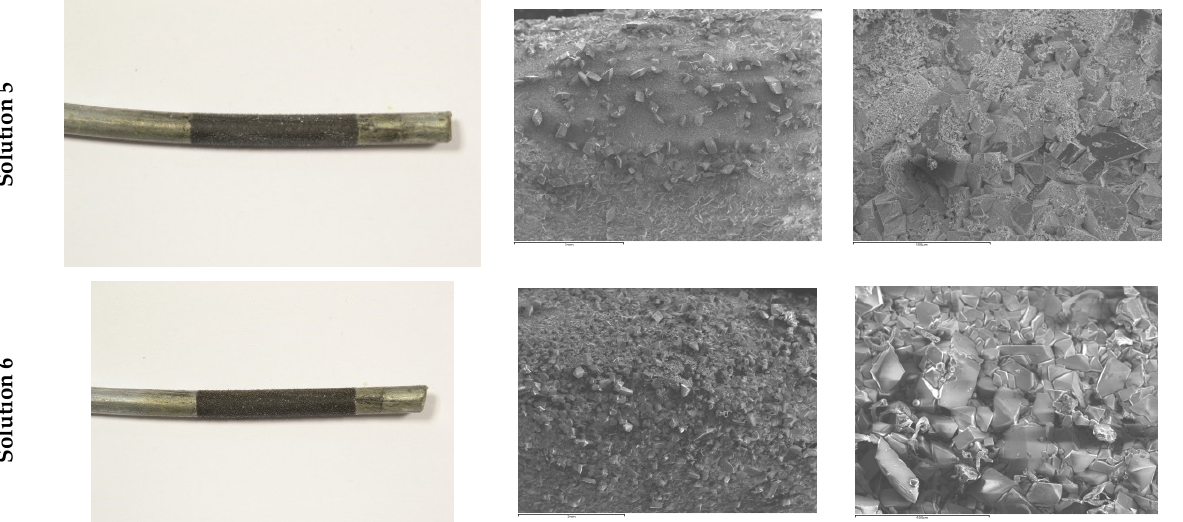
Figure 8. Optical microscopy and SEM results of the steel surfaces. Only one isolated white crystal of calcium hydroxyzincate Ca(Zn(OH) 3 ) 2 was found on the surface of the wire exposed to Solution 2. Due to the high pH of the solution, the crystal becomes larger and does not have the capacity to homogeneously coat the surface of the wire (Figure 9) [14]. By observing the SEM appearance of this crystal, it was possible to identify a totally different morphology from those observed on the surface of the other wires. Small crystallized threads can be observed.